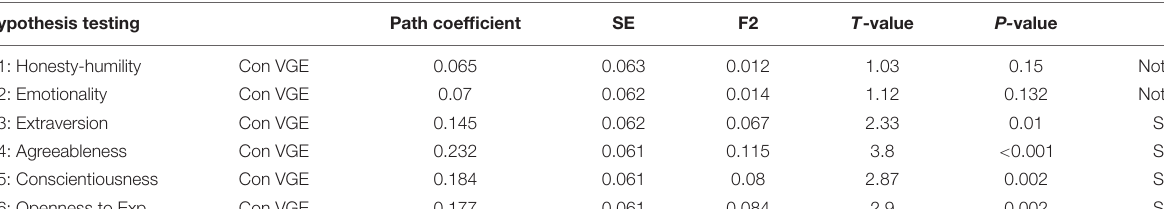
TABLE 6 | Assessment of the structural model.